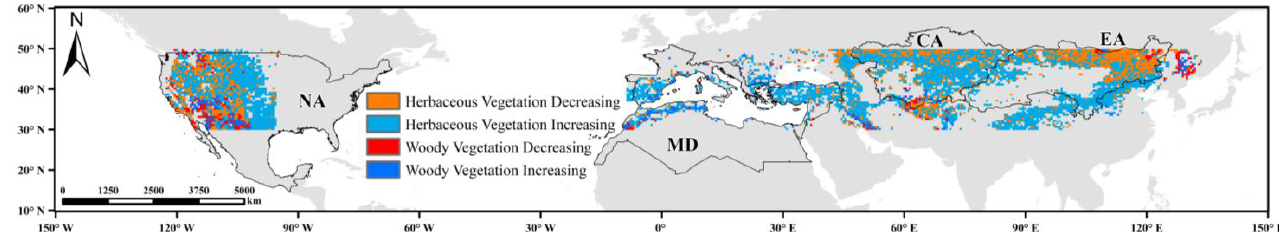
Figure A3. Spatial variation in vegetation LAI across the study area.